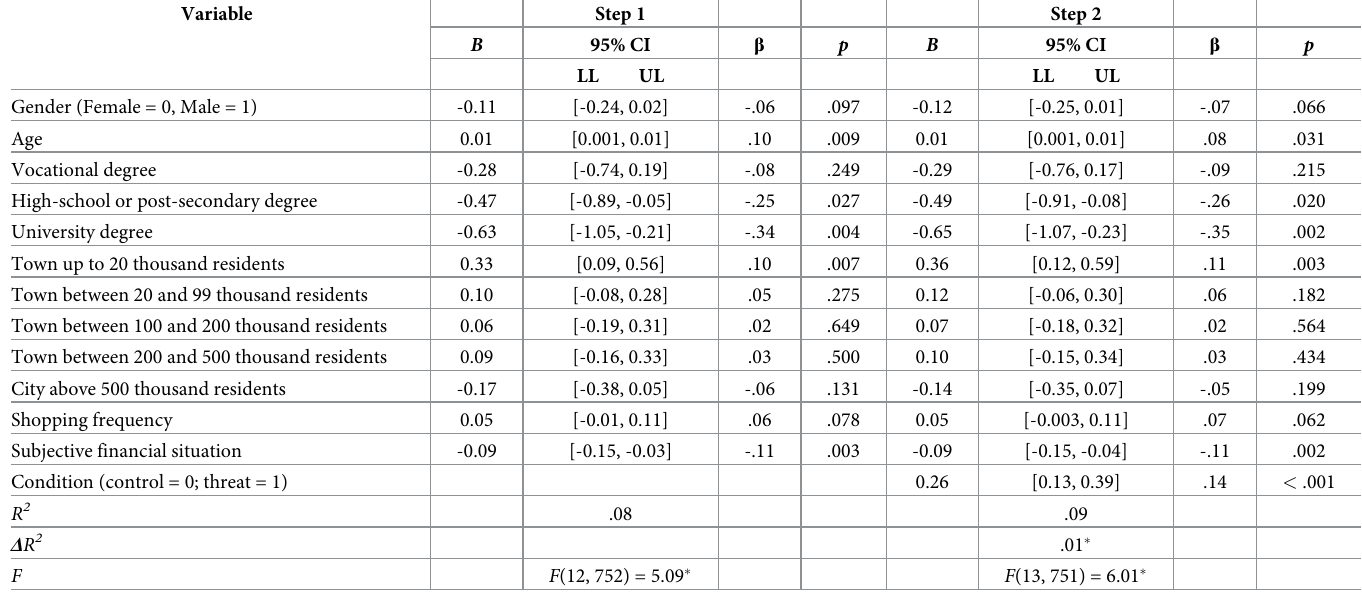
Table 4. Predictors of food industry conspiracy beliefs (Study 2).